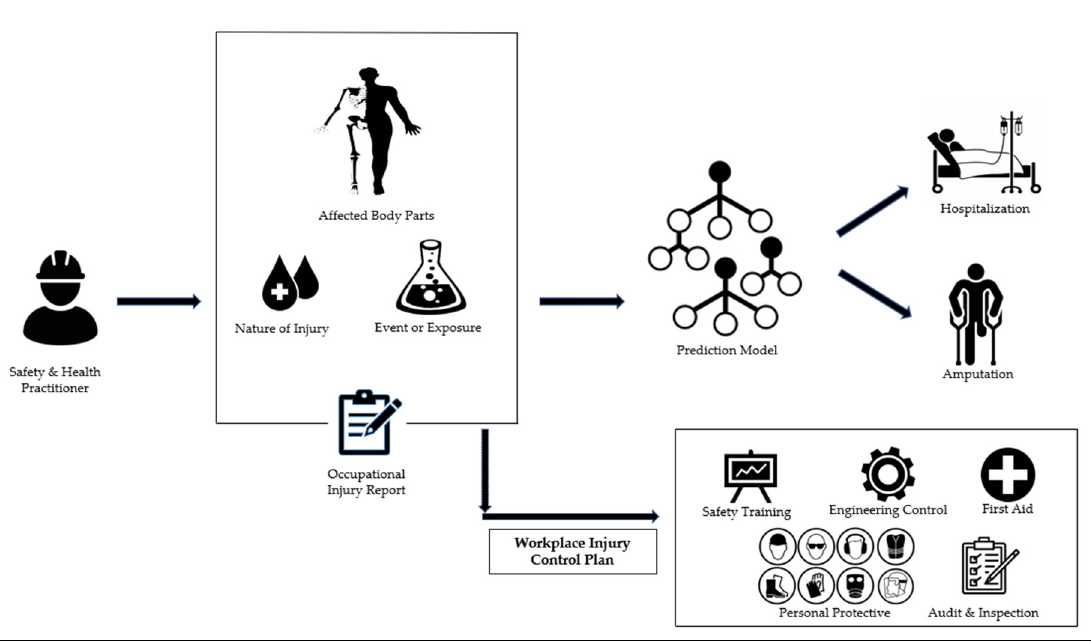
Figure 7. The proposed framework of AI-assisted occupational safety and health at workplace man- Figure 7. agement.